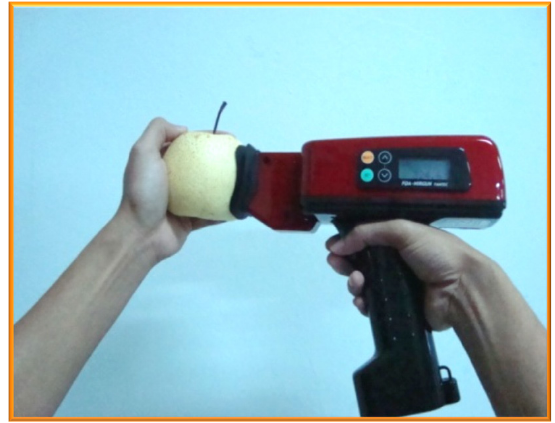
Fig. 1. The measuring of NIR spectrum on a pear in re°ec- tance mode using FQA-NIRGUN (Fantec, Japan).